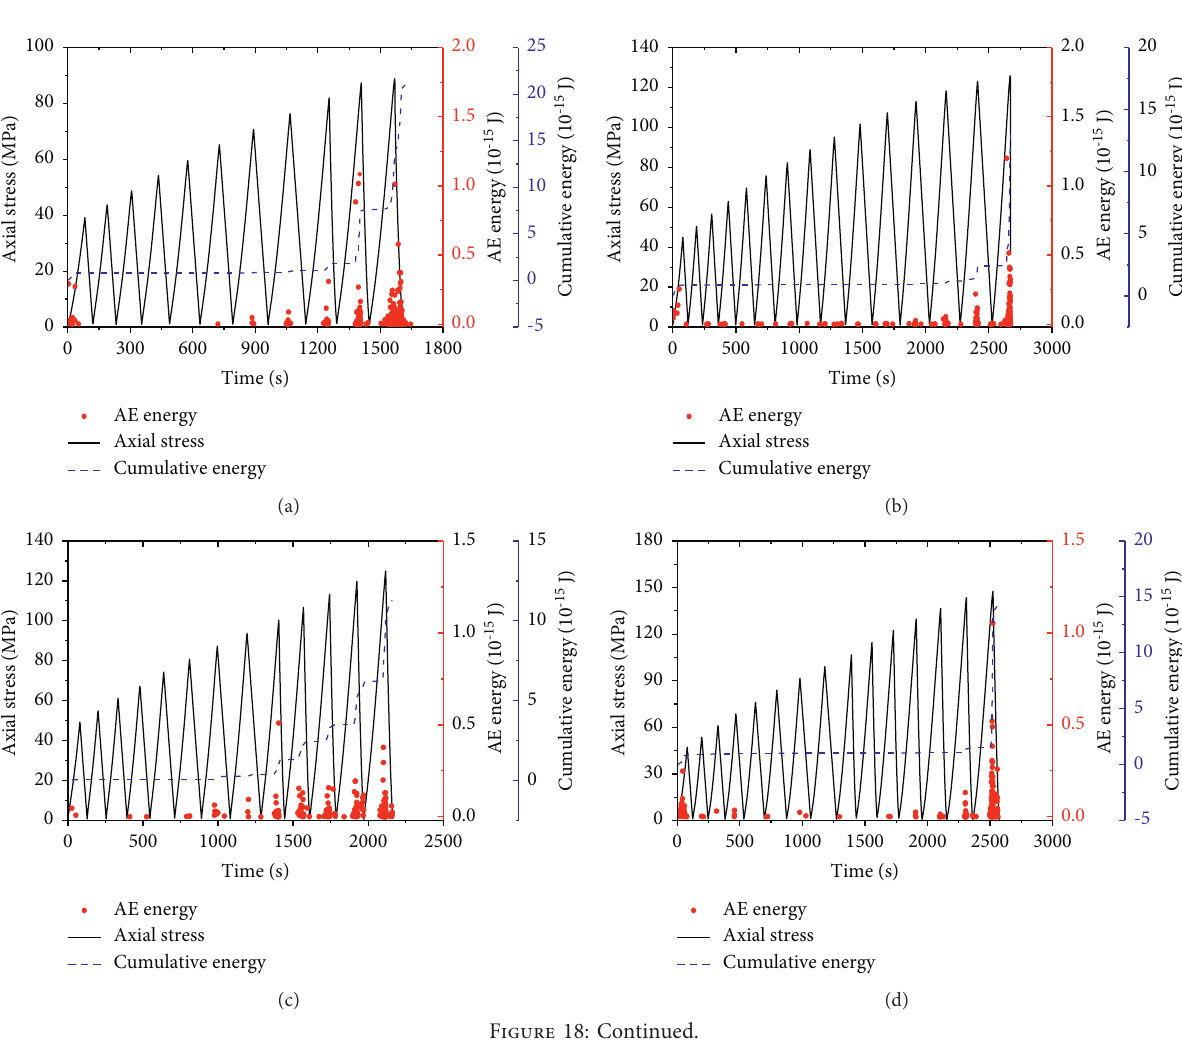
Figure 17: Sliding crack model.